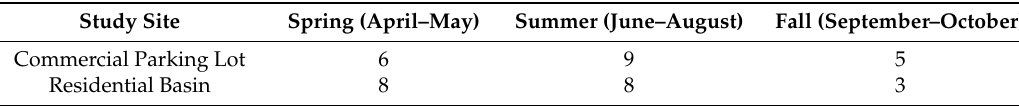
Table 1. Number of precipitation events sampled for the determination of PSD by season in the commercial parking lot and residential basin study